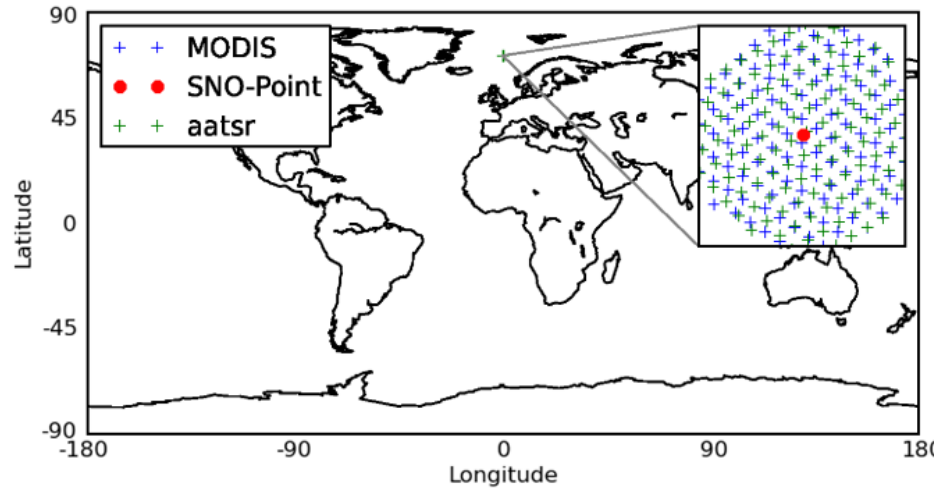
Figure 1. Target area for simultaneous nadir observation studies. Example shown for a SNO-point inter-comparing MODIS and AATSR